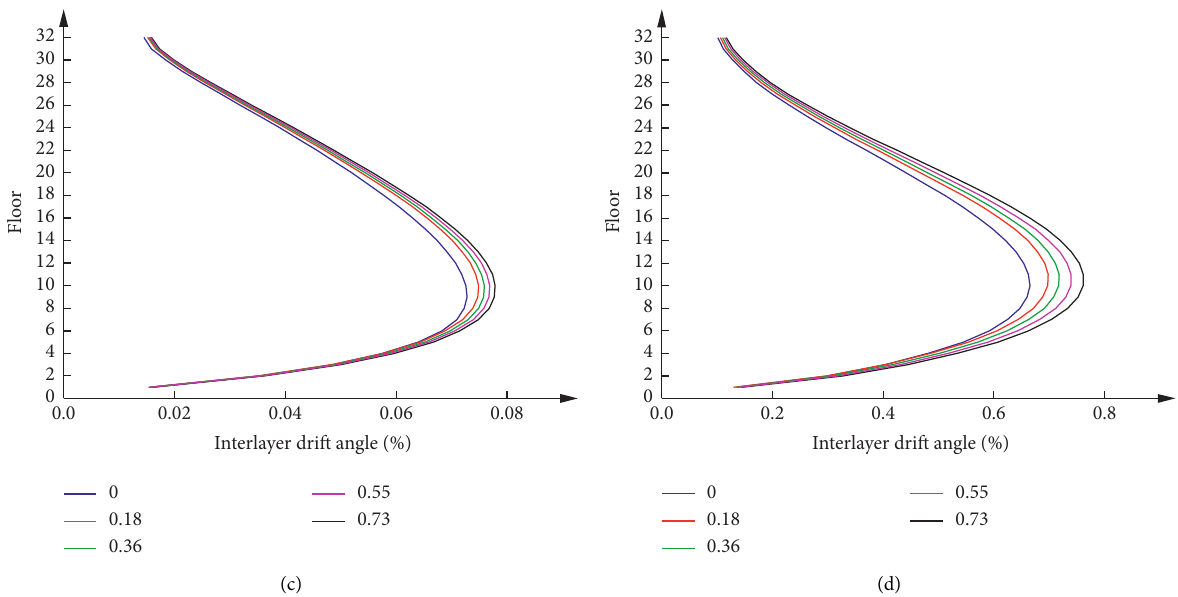
Figure 18: Effect of unbonded level on storey drift (a, b) and interlayer drift angle (c, d) in X direction. (a) Frequent earthquake. (b) Severe earthquake. (c) Frequent earthquake. (d) Severe